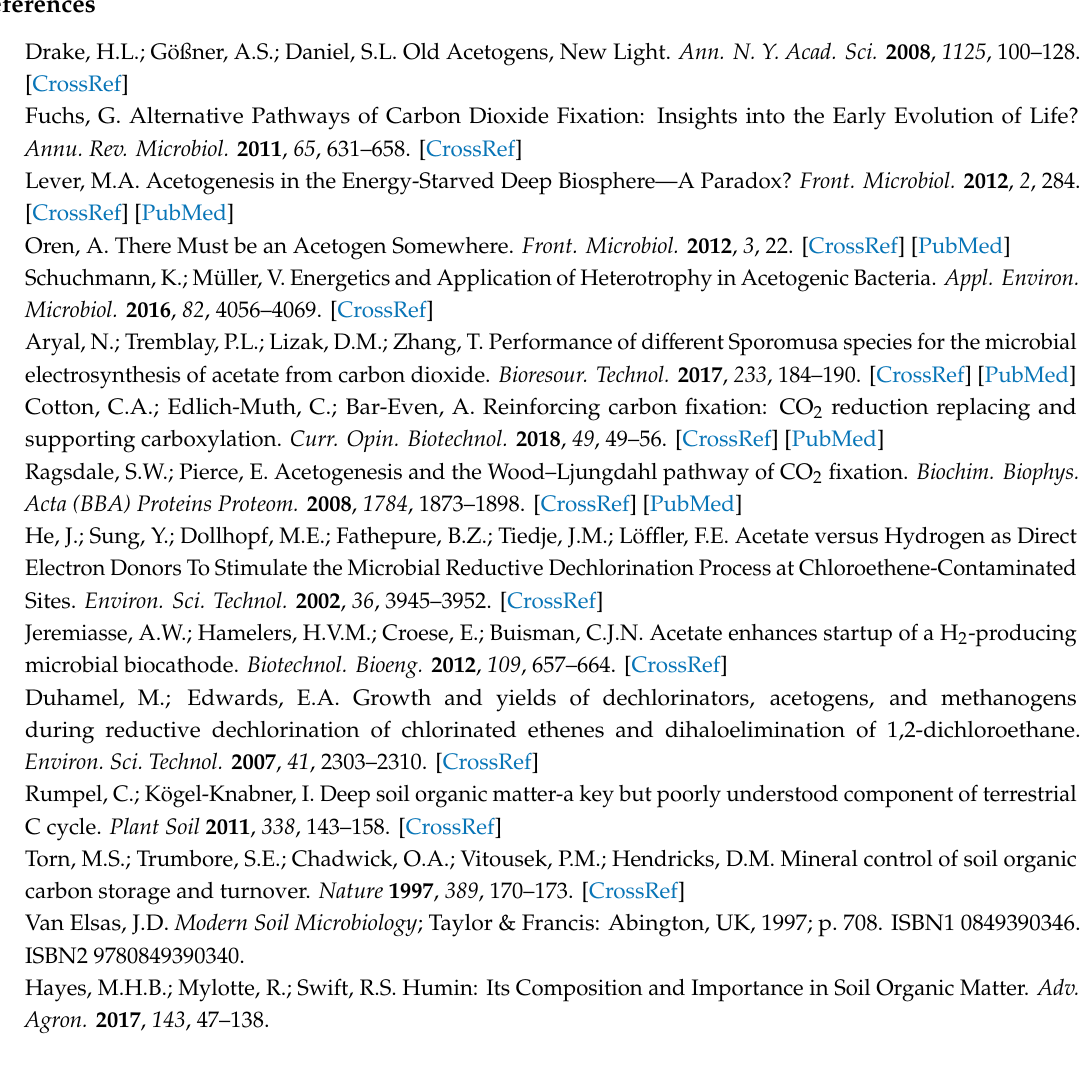
Table S1: Dechlorination metabolites detected in the timeline study using consortium PCPA0; Figure S1: Trend of acetate in consortium PCPA1 after two weeks incubation; Figure S2: Trend of dechlorination metabolites in consortium PCPA1 after two weeks incubation; Figure S3: Inorganic carbon as carbon dioxide in the mineral medium and headspace under the condition of PCPA0-C3; Figure S4: PCR products of consortium PCPA0